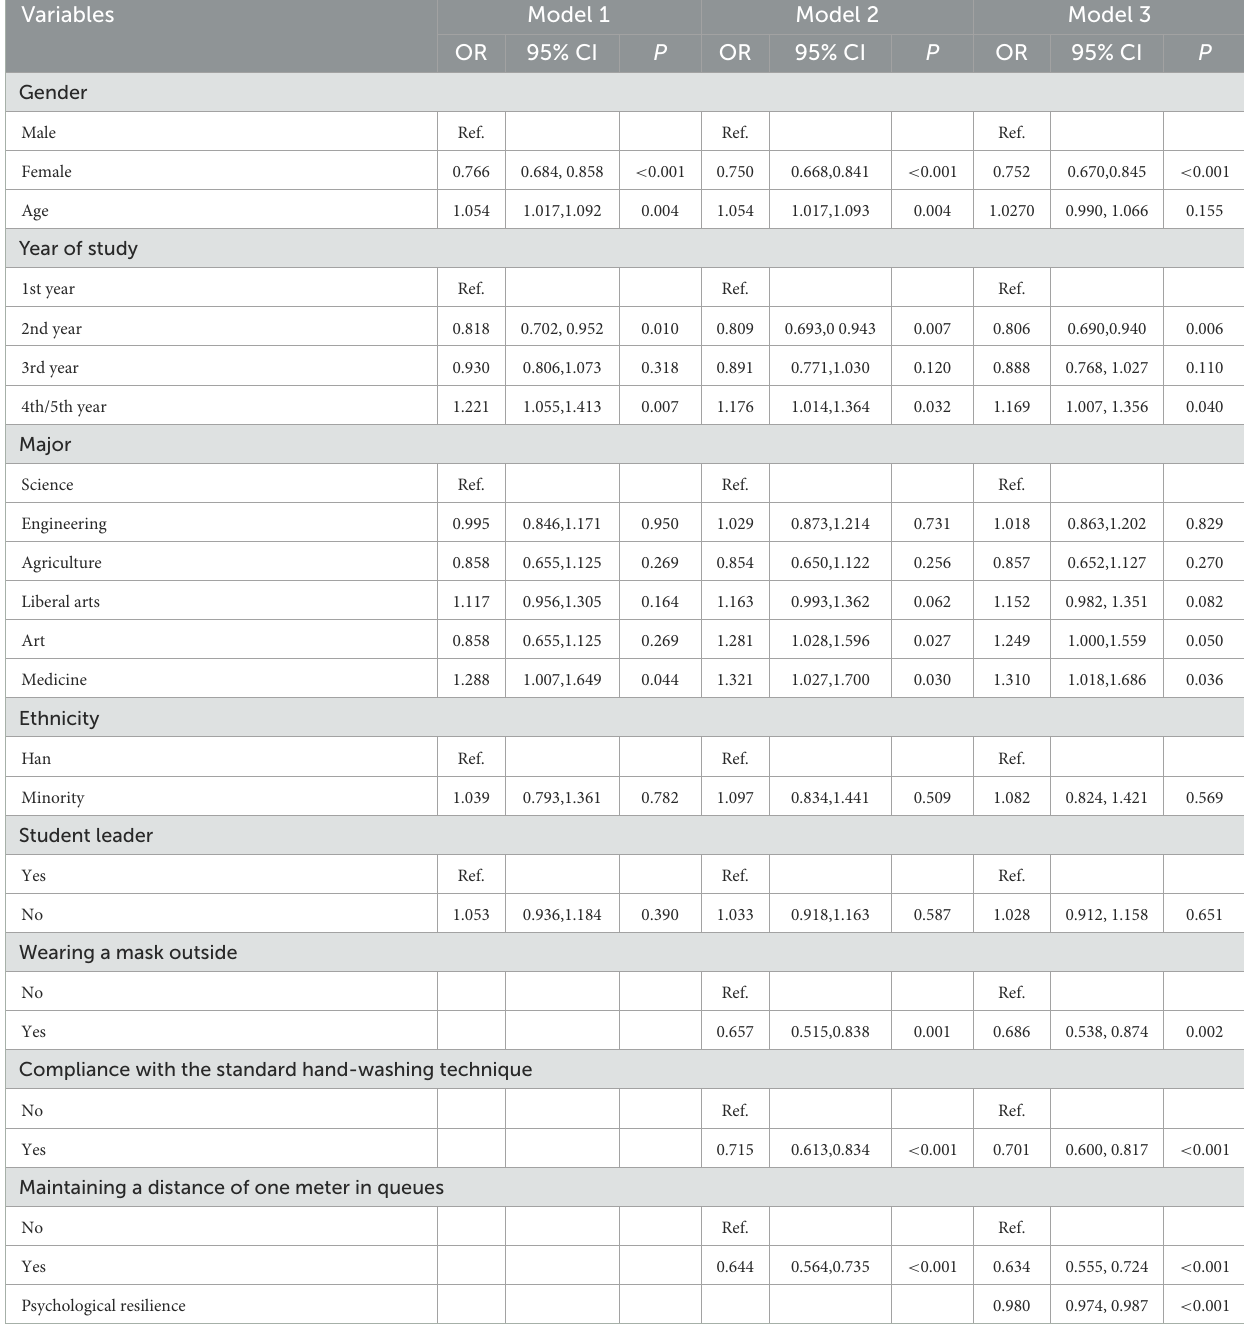
TABLE 4 Longitudinal associations of epidemic preventive behaviors and psychological resilience with anxiety based on GEE.